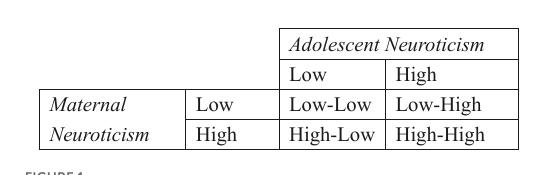
FIGURE1 Maternal neuroticism and adolescent neuroticism combination